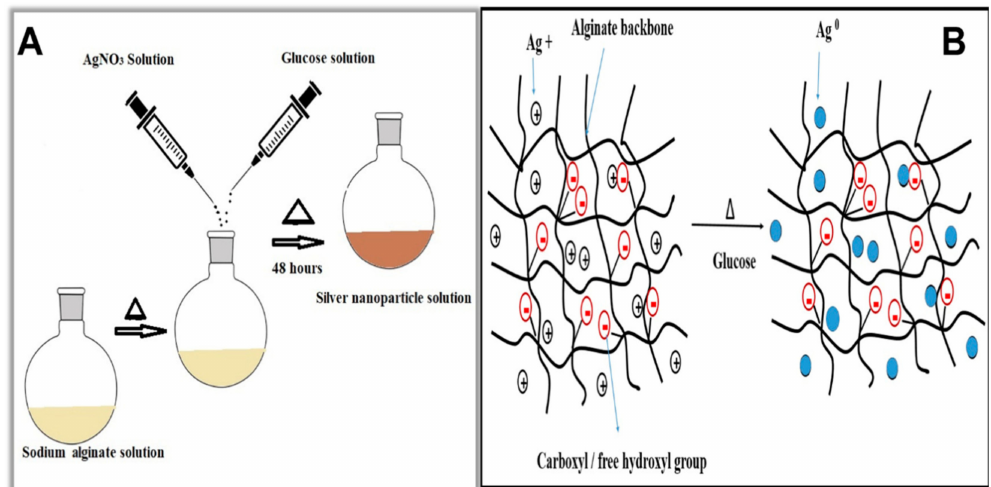
Figure 1. ( A ) Schematic representation of the synthesis of sodium alginate-capped silver nanoparticles (Ag-NPs). ( B ) Schematic representation of the formation of sodium alginate-capped Ag-NPs.